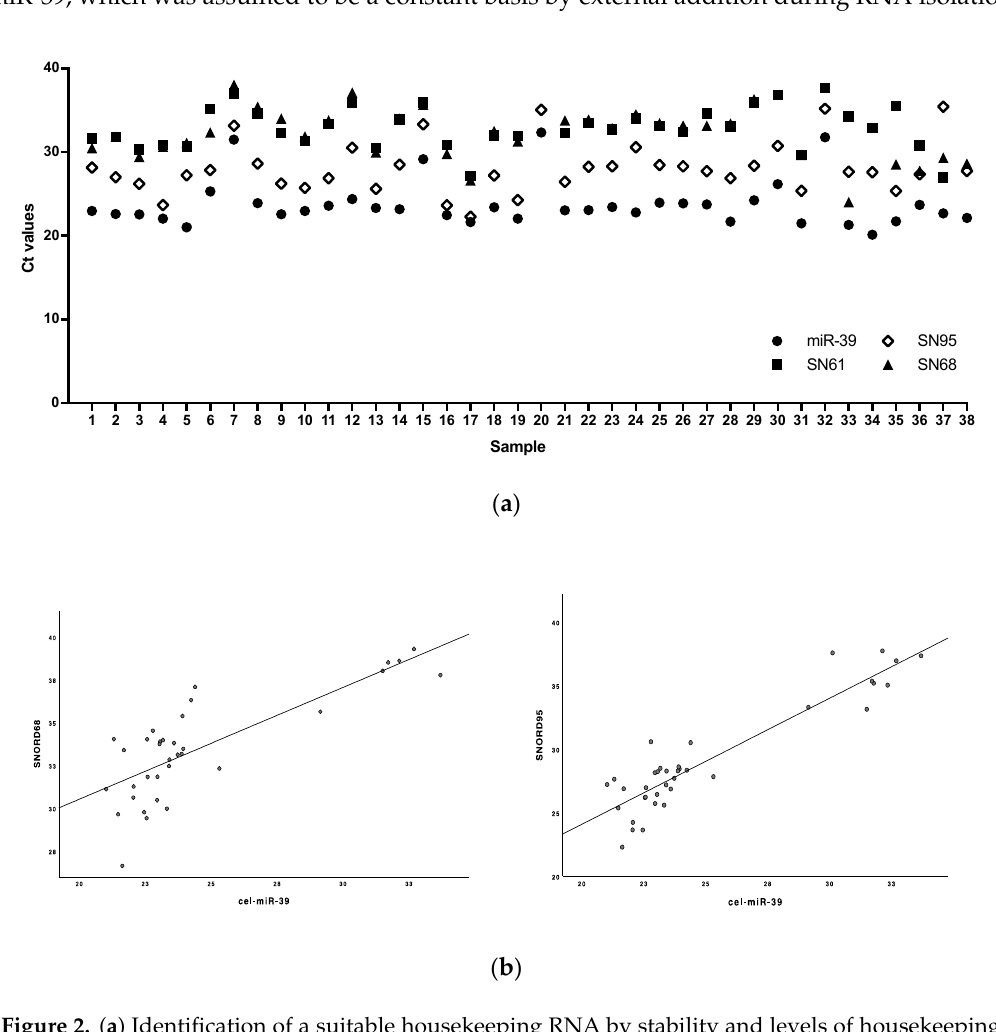
Figure 2. ( a ) Identification of a suitable housekeeping RNA by stability and levels of housekeeping snoRNA (Ct values of SNORD61, SNORD68, SNORD95) and ( b ) correlation of SNORD68 (left) and SNORD95 (right) with exogenous spike-in control (Ct values of cel-miR-39). It was found that SNORD95 was stably present in all n = 38 serum samples. Both SNORD61 and SNORD68 were detected in n = 36 samples. The Ct value and normalized ∆ Ct value ( ∆ Ct = Ct cel-miR-39 − Ct SNORD ) were significantly lowest for SNORD95 ( ∆ Ct 4.3 ± 2.1) compared to SNORD61 ( ∆ Ct 10.0 ± 5.1, p < 0.001) and SNORD68 ( ∆ Ct 8.7 ± 2.4, p < 0.001). For SNORD61 (Pearson correlation